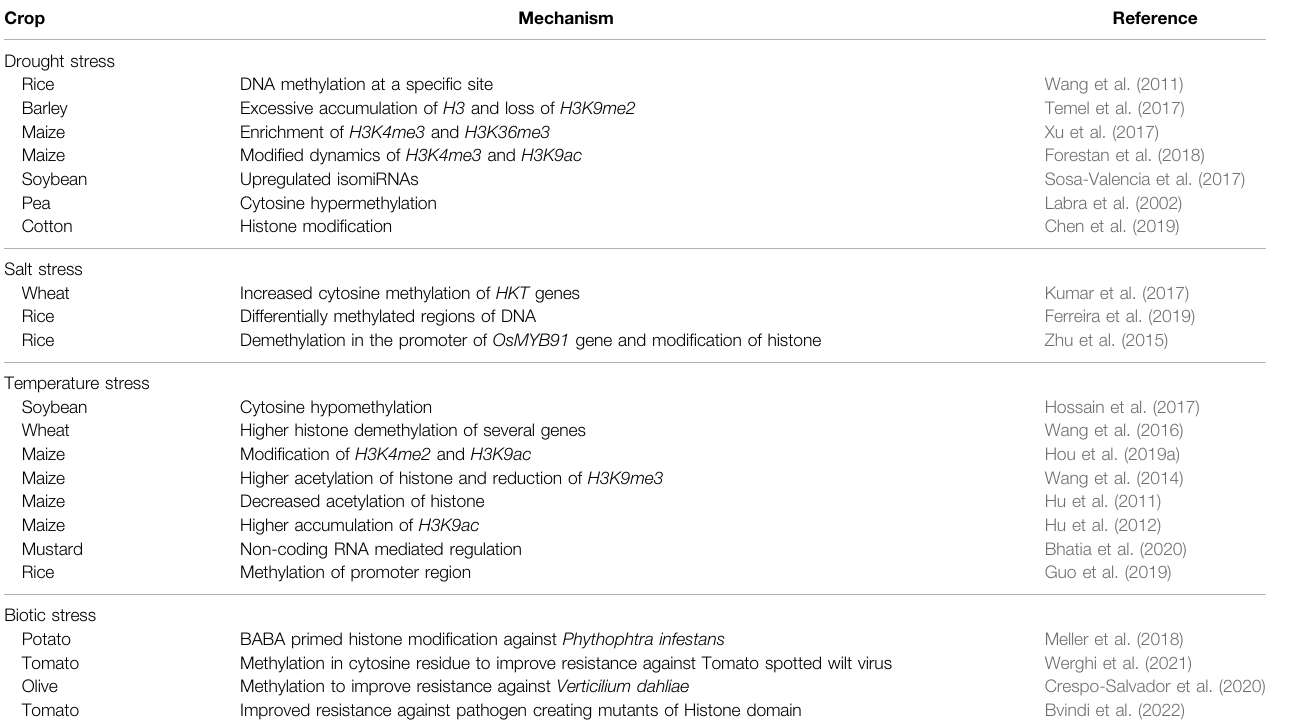
TABLE 1 | Stress-related epigenetic mechanisms for improved crop development under stress conditions.